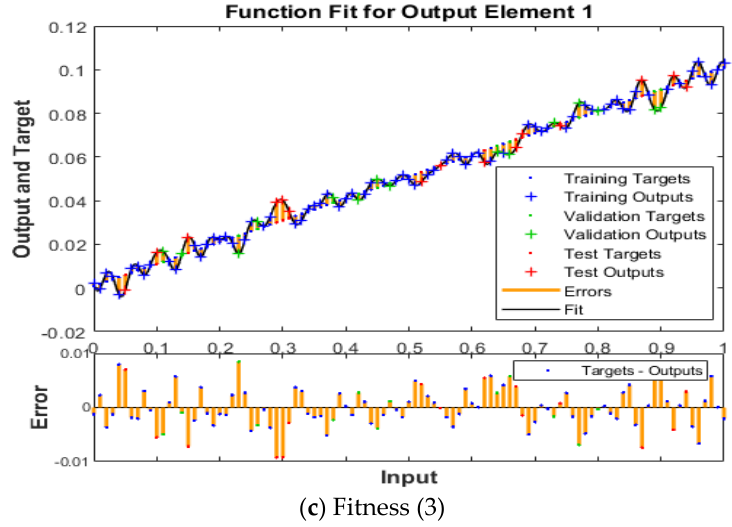
Figure 5. Function fitness for solving the nonlinear dynamics of MTS.